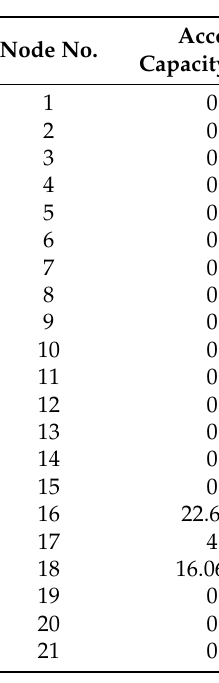
Table 3. DG locating and sizing information.